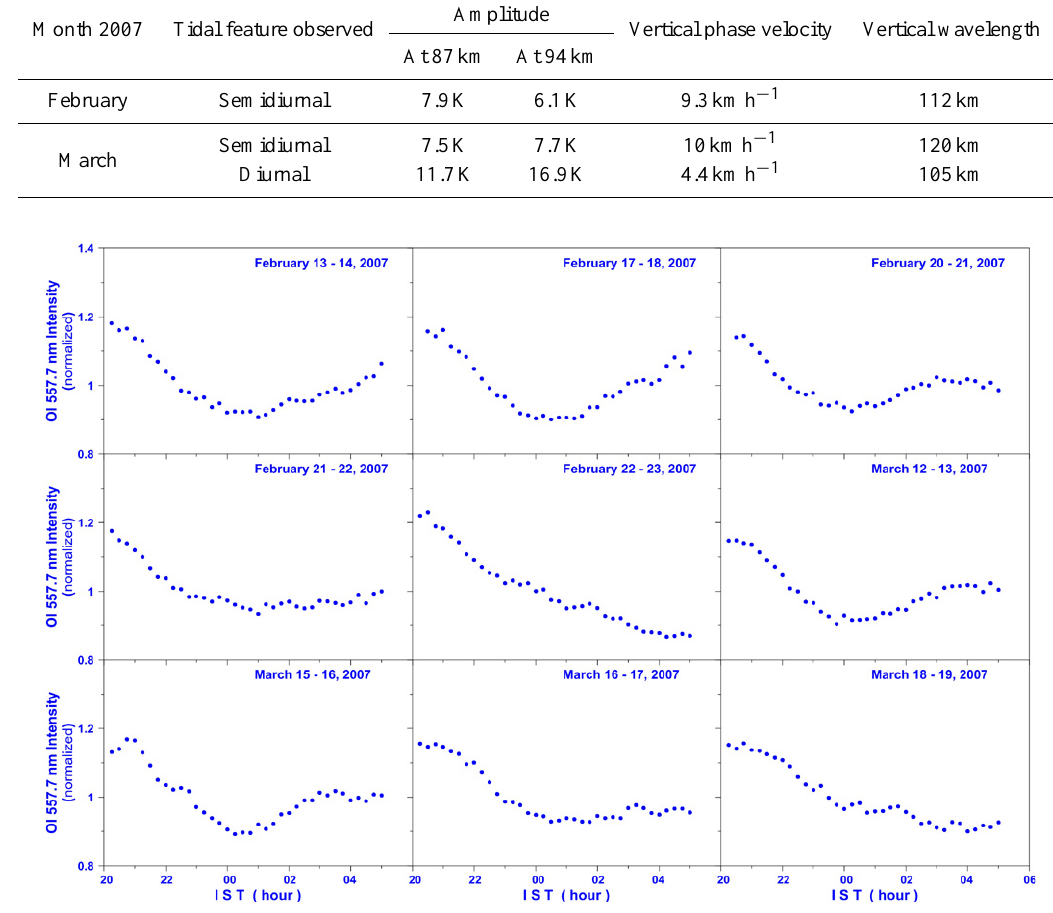
Fig. 8. Nocturnal variation of OI 557.7nm emission intensity on some nights during February–March 2007 at